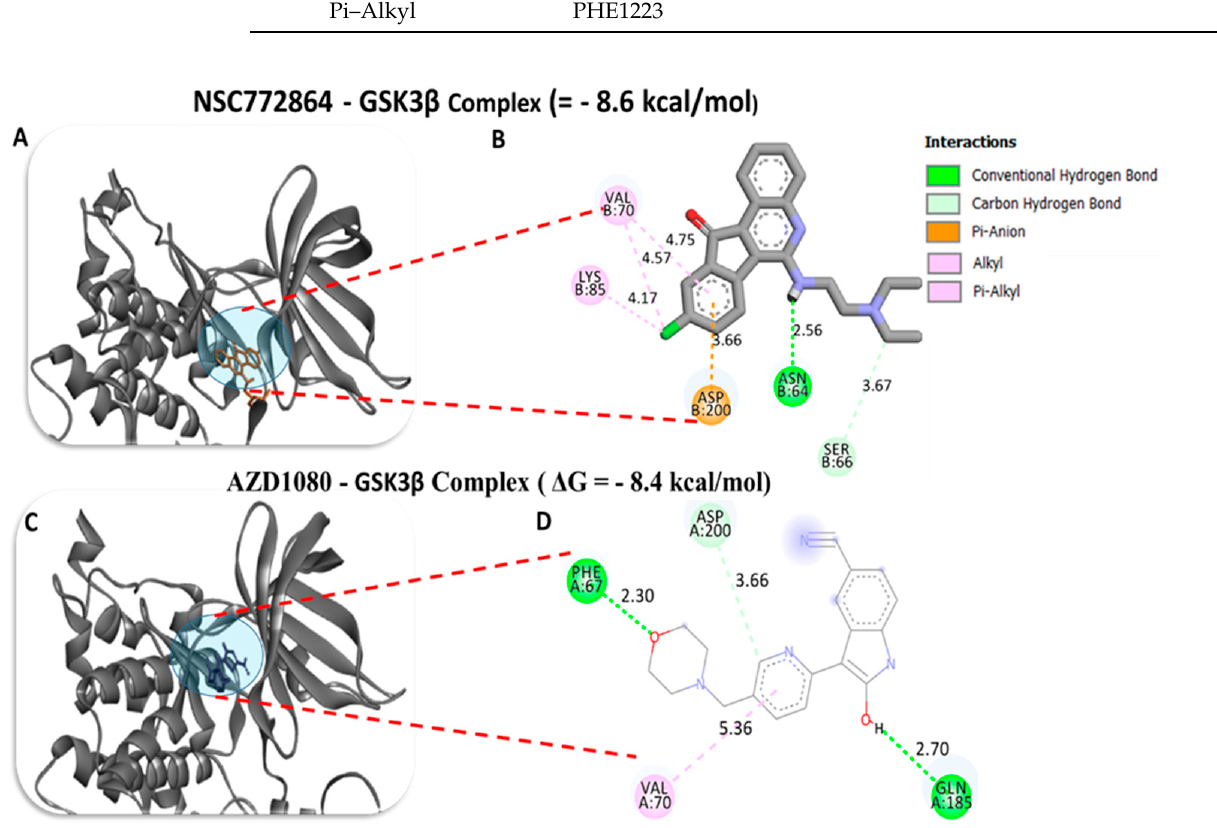
Figure 13. Docking profiles of GSK3 β with NSC772864 and standard inhibitors. ( A , B ) NSC772864 bound with GSK3 β with Gibbs’ free energy ( ∆ G) of − 8.6 kcal/mol. ( C , D ) Binding of AZD1080 with GSK3 β showed a slightly higher affinity of ∆ G = − 8.4 kcal/mol compared to NSC772864. Table 4 gives binding energies of ligand–receptor interactions, including different types of interactions and the amino acid residues involved. Table 4. NSC772864 and standard drug comparative docking profiles against GSK3 β .